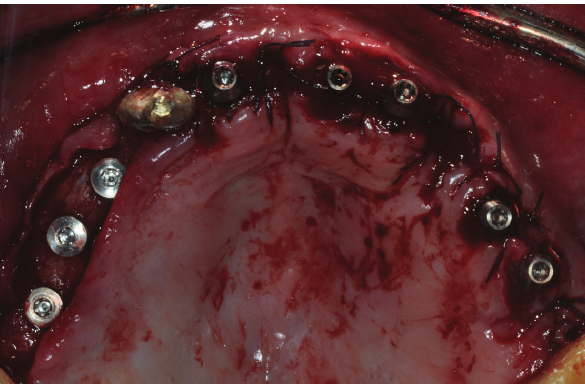
Figure 4: Implant